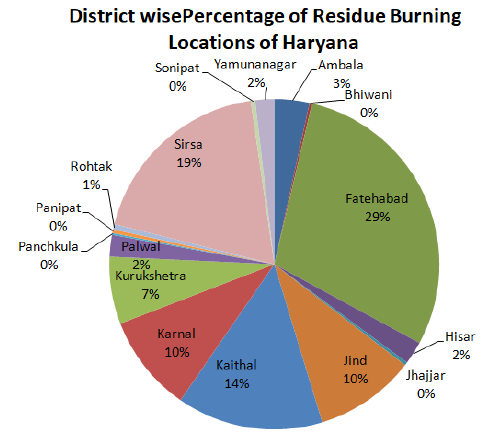
Figure7. Maximum rice residue burning period of Haryana